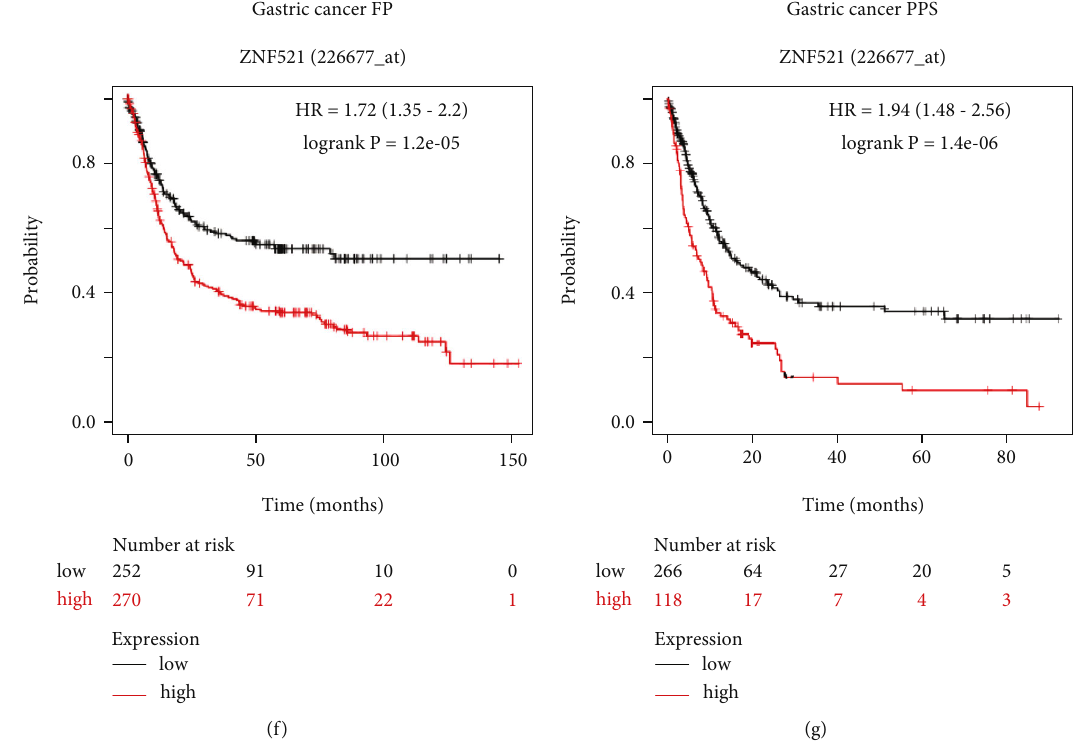
Figure 2: The correlation between ZNF521 expression and patient prognosis. (a) – (d) Kaplan – Meier curves with univariate analyses (log- rank) for the patients with low ZNF521 expression versus the high ZNF521 expression tumors. (e) – (g) The correlation between ZNF521 and prognosis of gastric cancer in the Kaplan – Meier plotter databases (K – M) survival curves of OS, FP, and PPS in Gastric